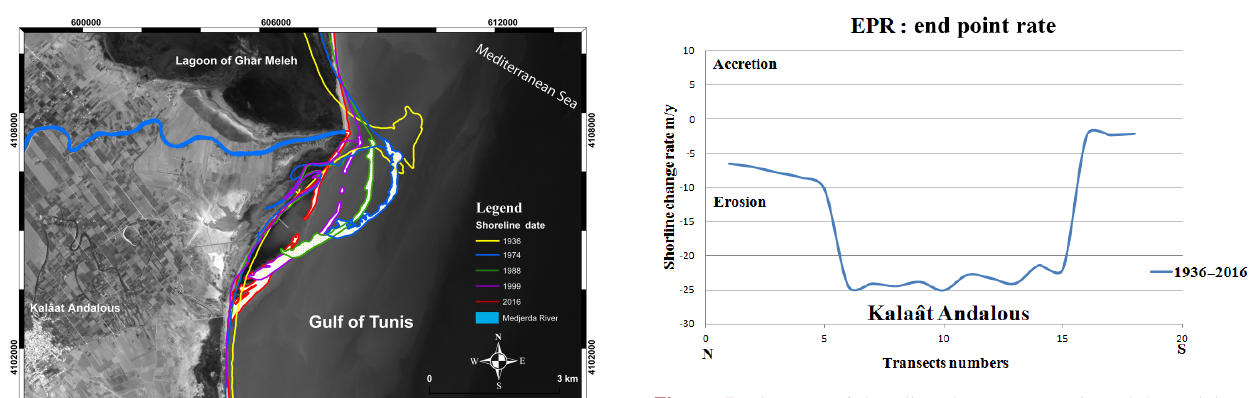
Figure 5. The rates of shoreline changes (EPR) in Kalaât Andalous.